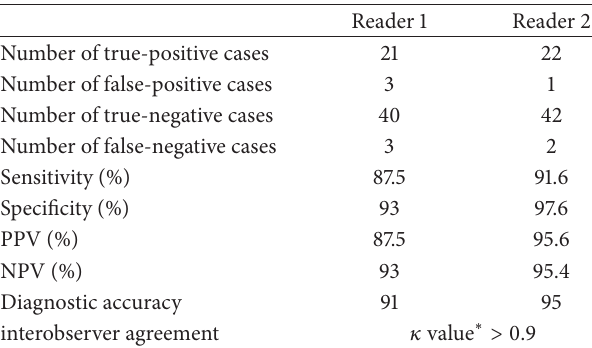
Table 1: Results of MR enteroclysis in the diagnosis of small-bowel neoplasms in our sample data for readers 1 and